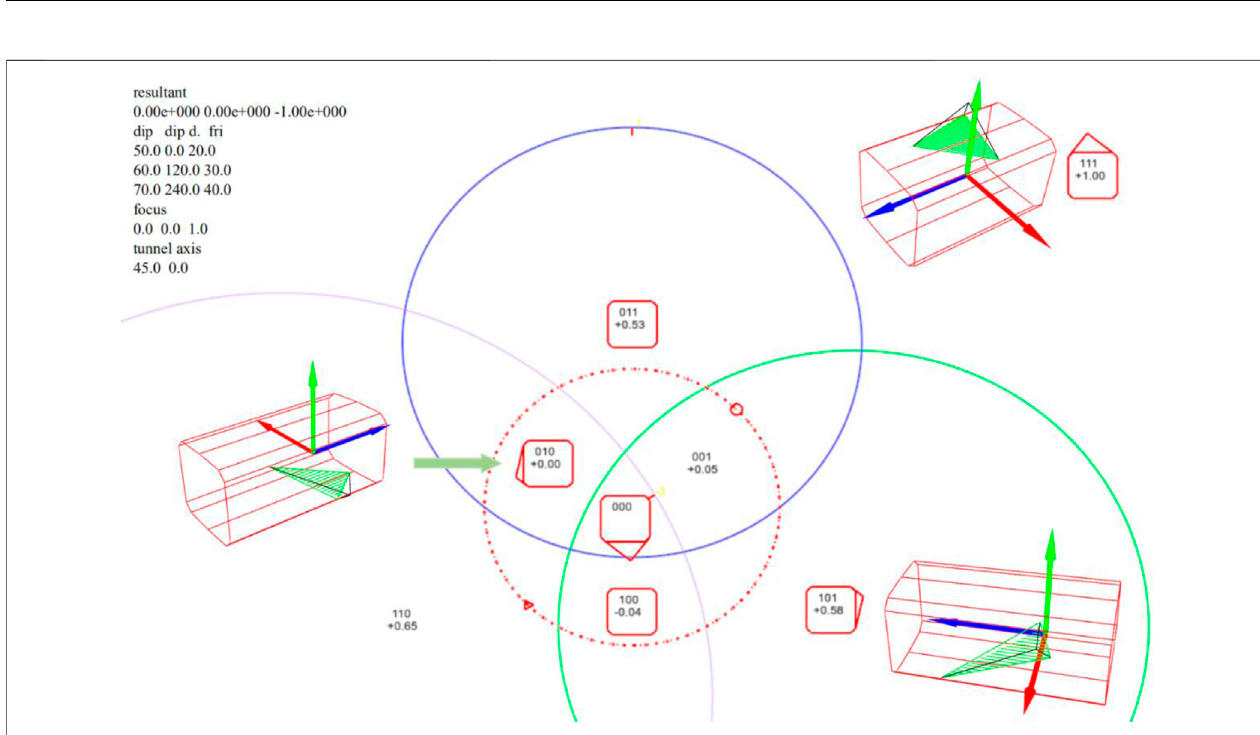
pyramid (JP) and evacuation pyramid (EP). As shown in Figure 1A , four key blocks are generated considering the intersection of orange and green joint sets and the tunnel boundary. In Figure 1B , joint pyramid codes of the blocks at the surface of a tunnel are shown; the label “ 01 ” means above an orange joint plane and below a green joint plane. The removability of blocks can be analyzed by the joint pyramid of convex blocks.